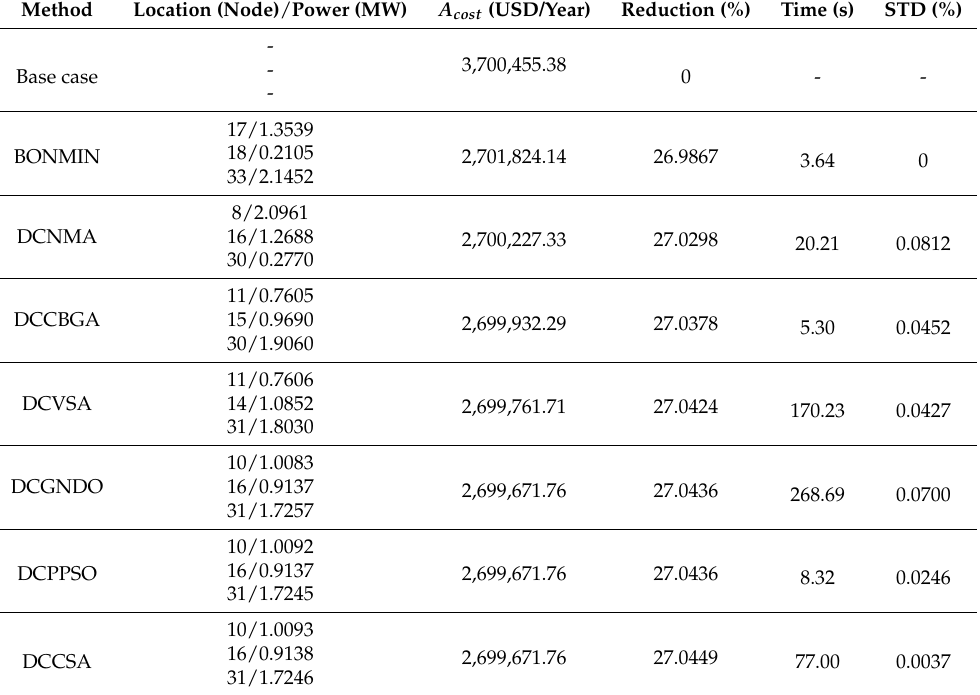
Table 3. Numerical results obtained in the 33-node test